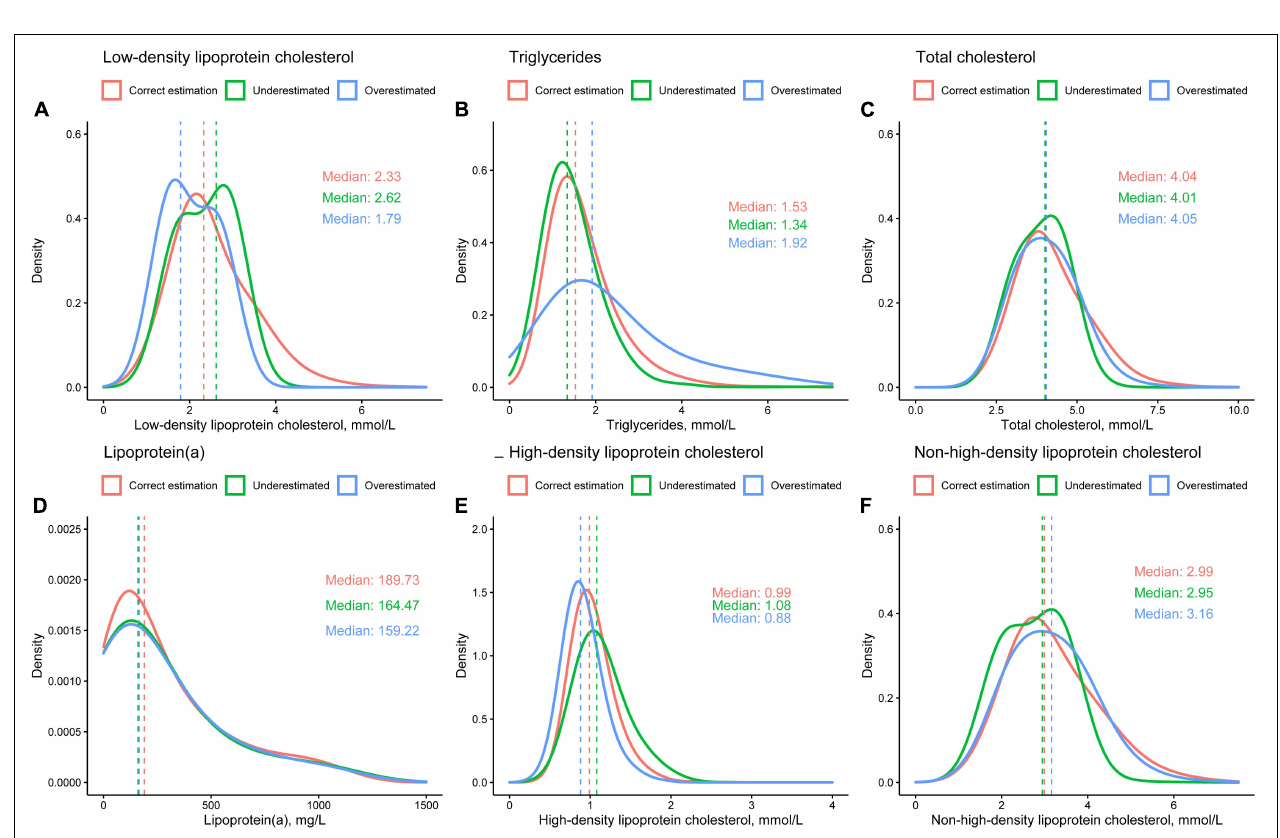
FIGURE 5 | Distributions of (A) directly measured low-density lipoprotein cholesterol, (B) triglycerides, (C) total cholesterol, (D) lipoprotein(a), (E) high-density lipoprotein cholesterol, and (F) non-high-density lipoprotein cholesterol.